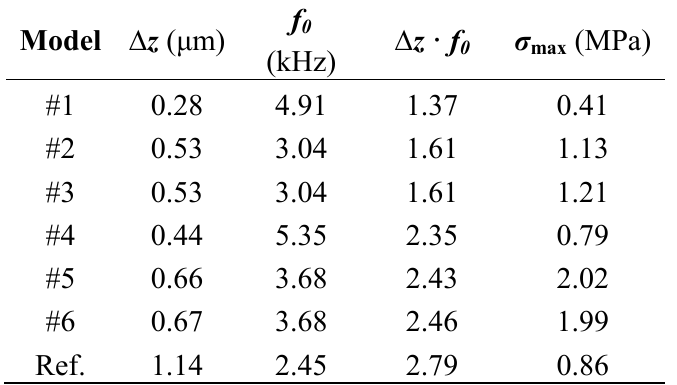
Table 3. Comparison between simulation values for maximum deflection, fundamental resonant frequency, sensitivity and maximum induced